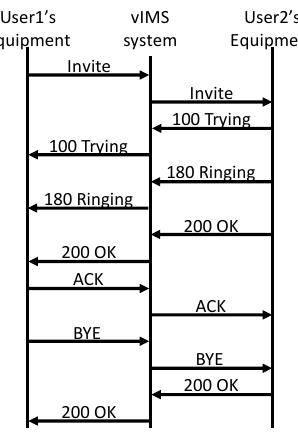
Figure 10. SIP call flow.